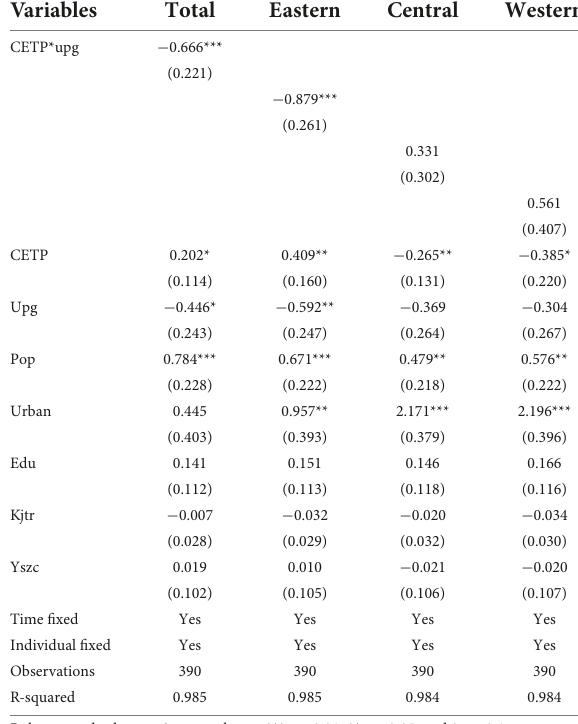
TABLE 6 Industrial structure upgrading interaction